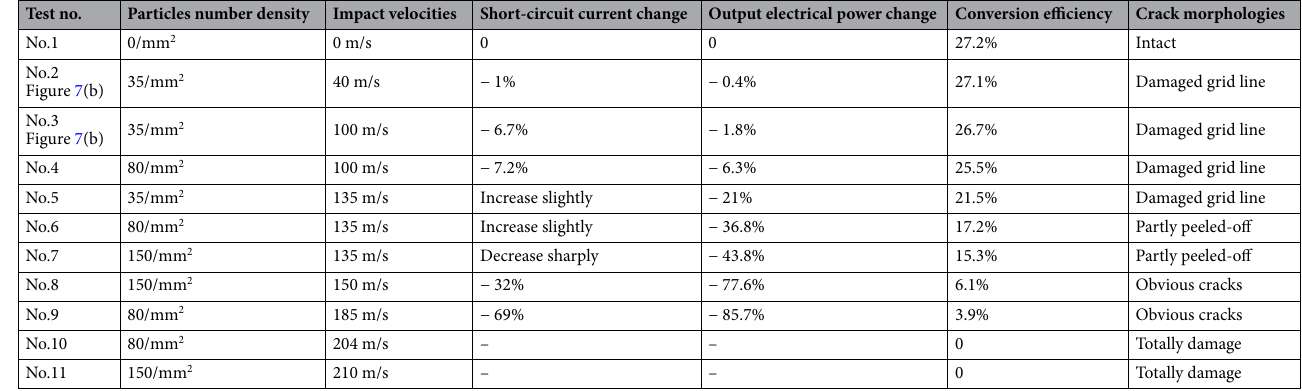
Table 1. Light-electricity conversion performance of the PV cells before and after